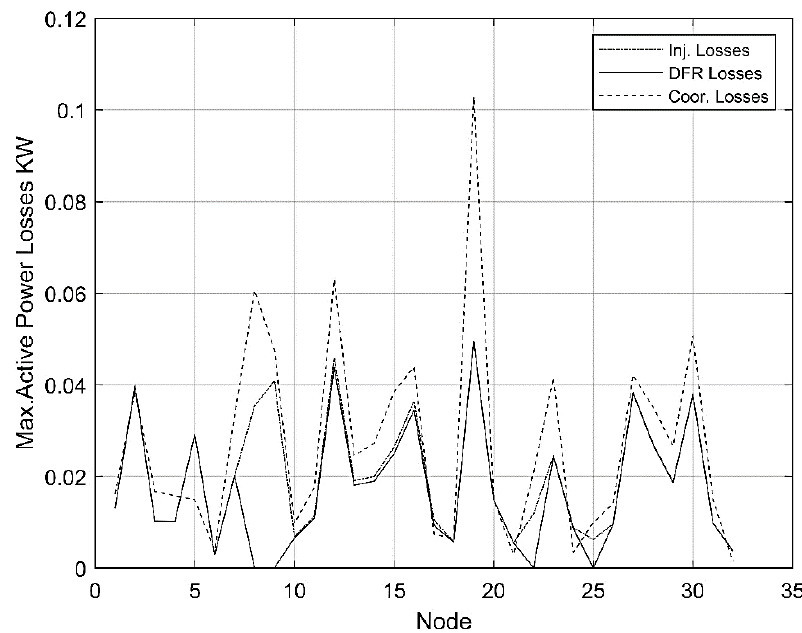
Figure 10. Power losses comparison of three techniques at nodes.